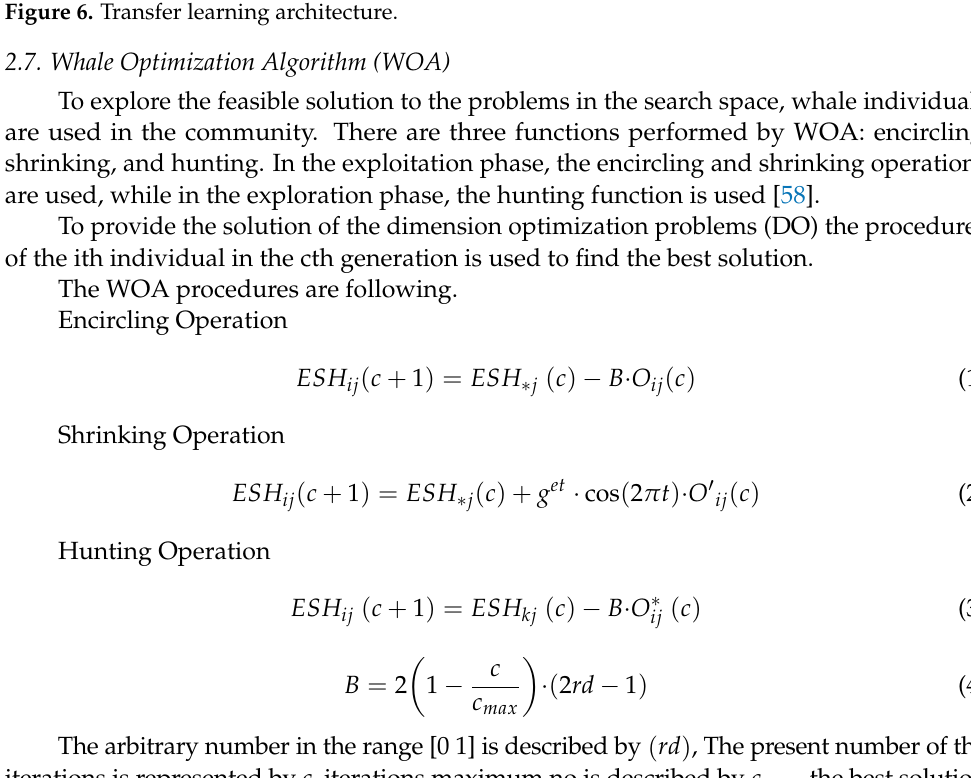
Figure 6. Transfer learning architecture .